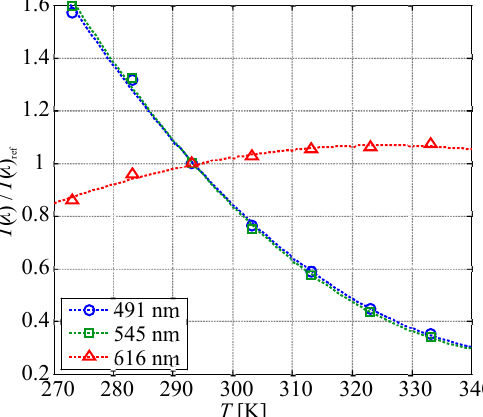
Figure 7. I ( λ ) / I ( λ ) ref plotted as a function of temperature at P = 100